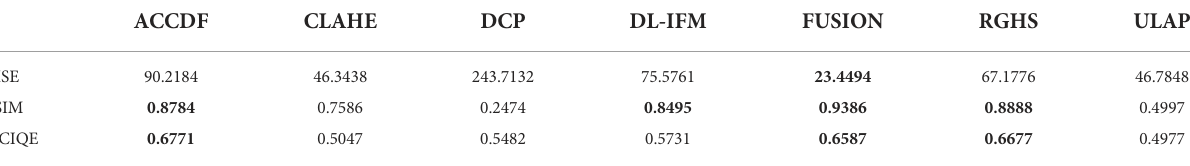
TABLE 2 Quality evaluation of Figure 7F